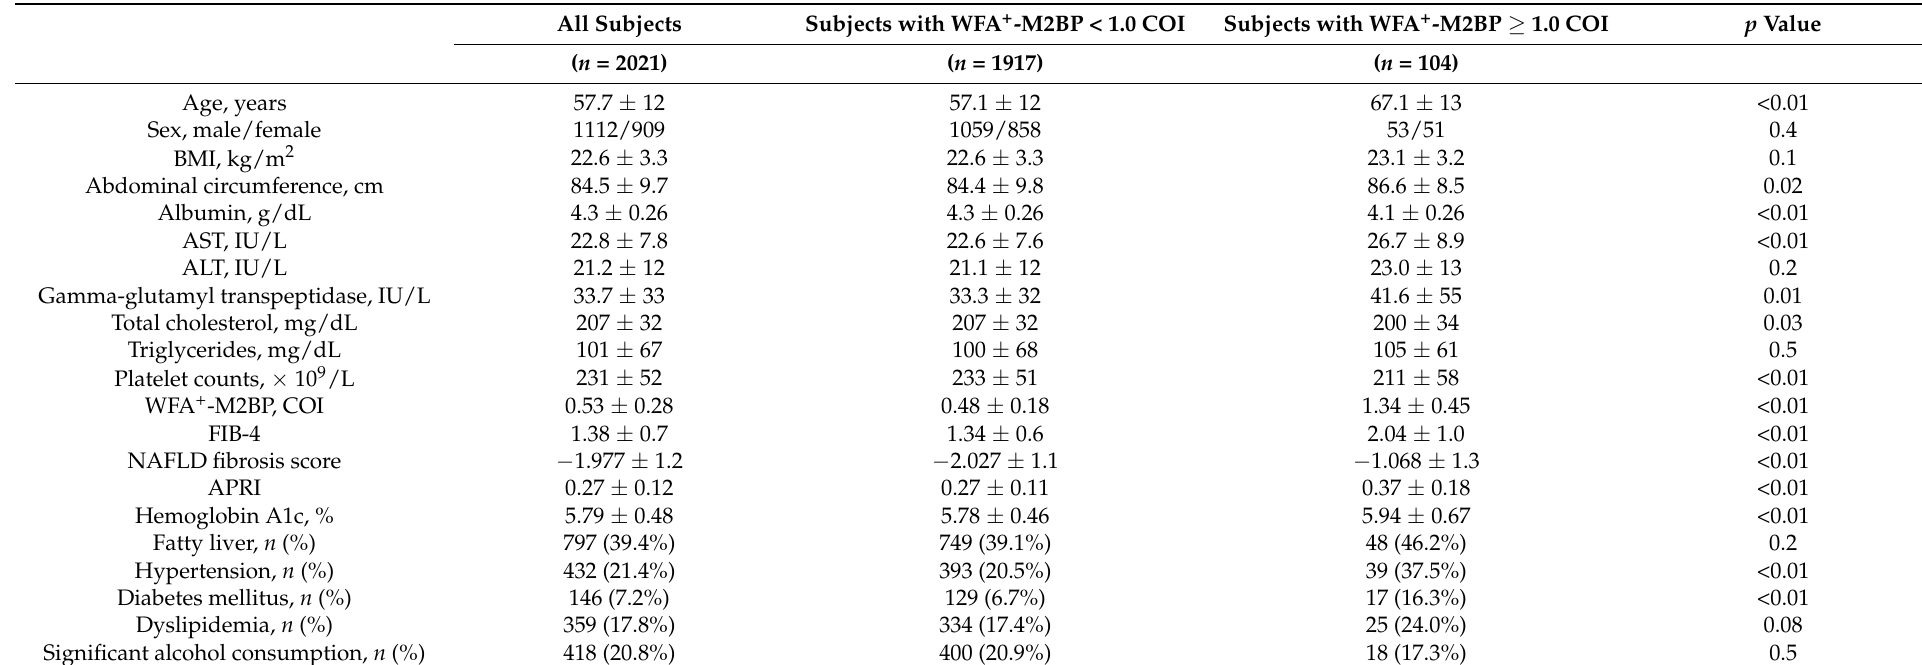
Table 1. Subject